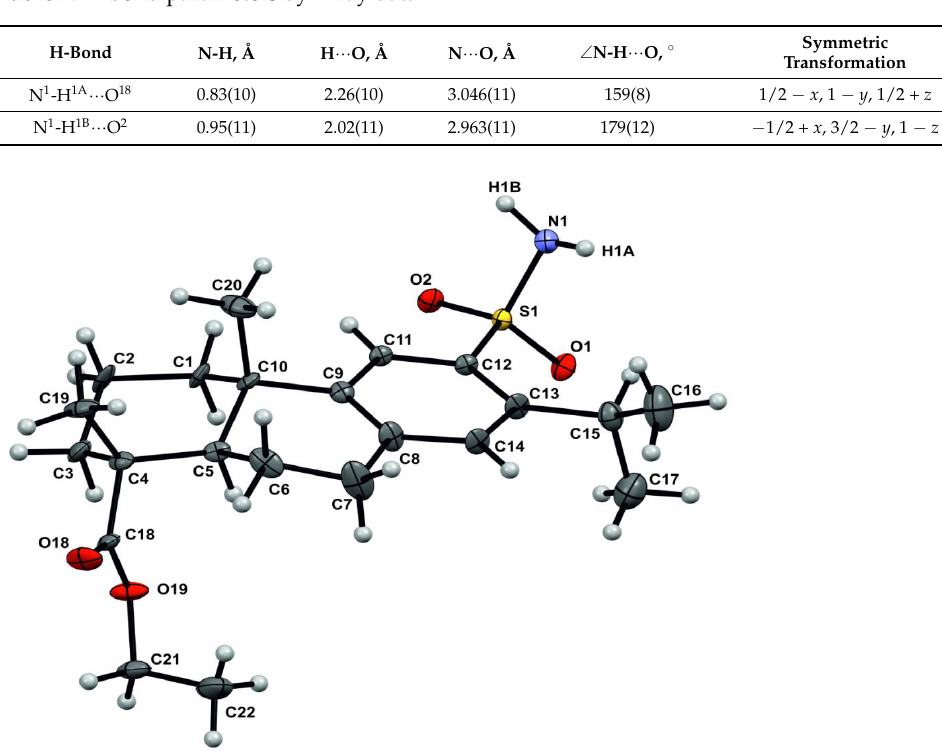
Table 1. H-bond parameters by X-ray data.